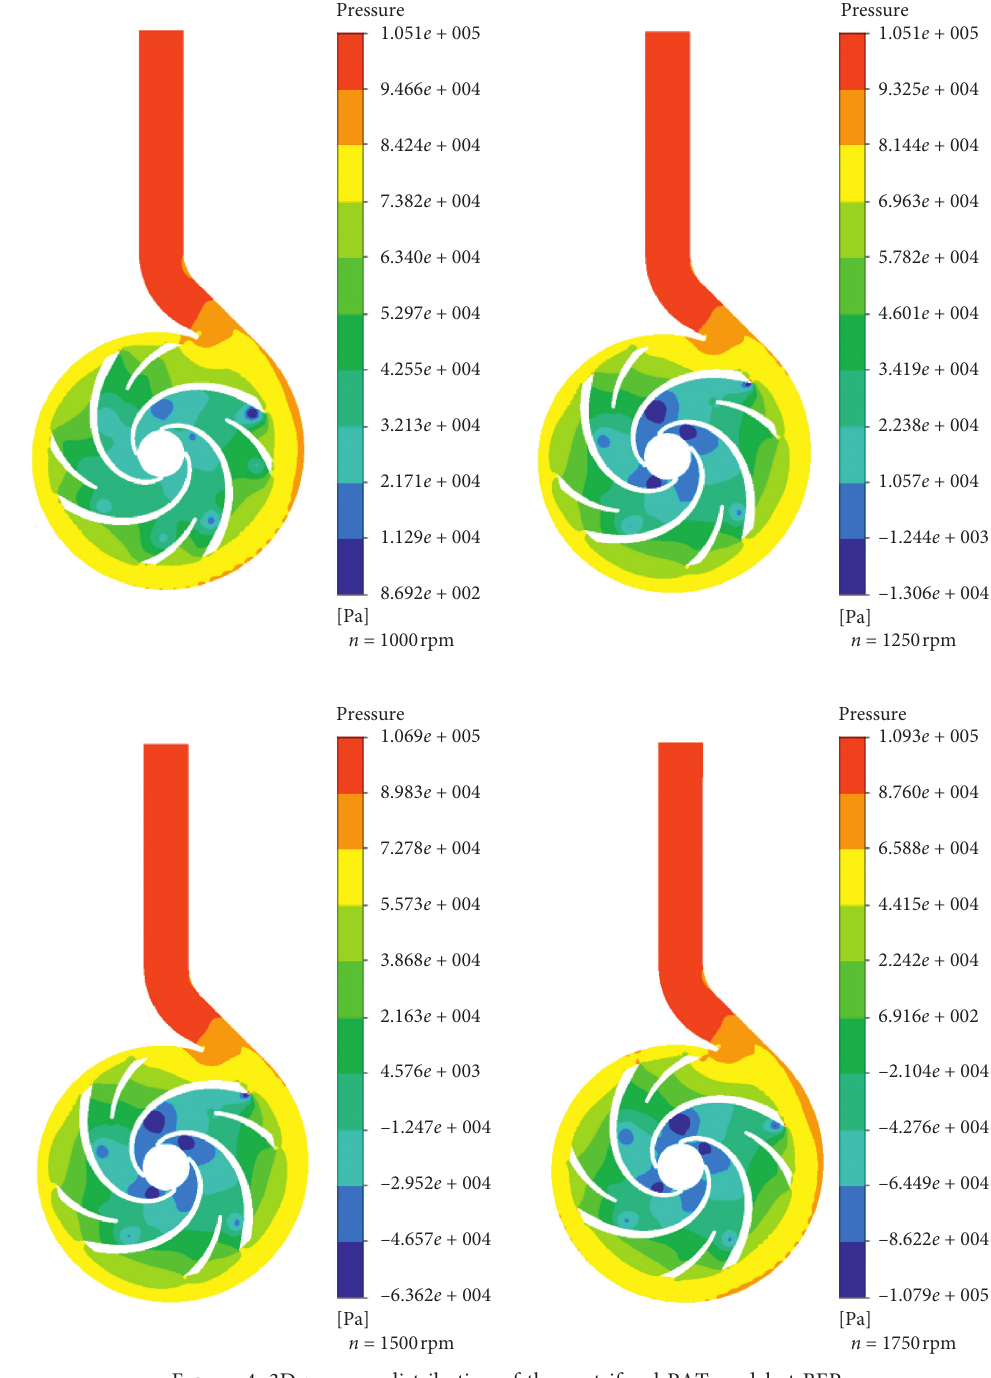
Figure 4: 3D pressure distribution of the centrifugal PAT model at